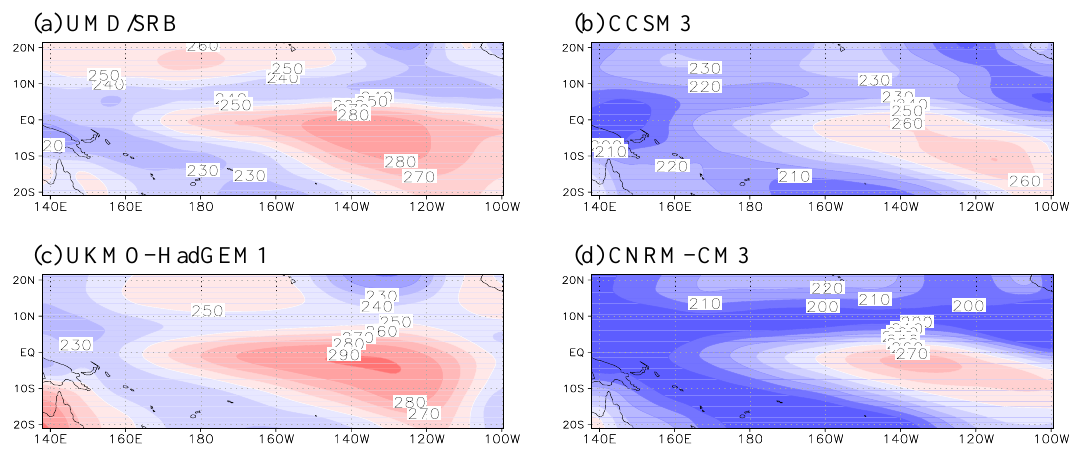
Fig. 1. Distribution of SW ↓ surf over the tropical Pacific in Wm − 2 from satellite estimates: (a) UMD/SRB and AMIP II models: (b) CCSM3; (c) UKMO-HadGEM1; (d) CNRM-CM3.